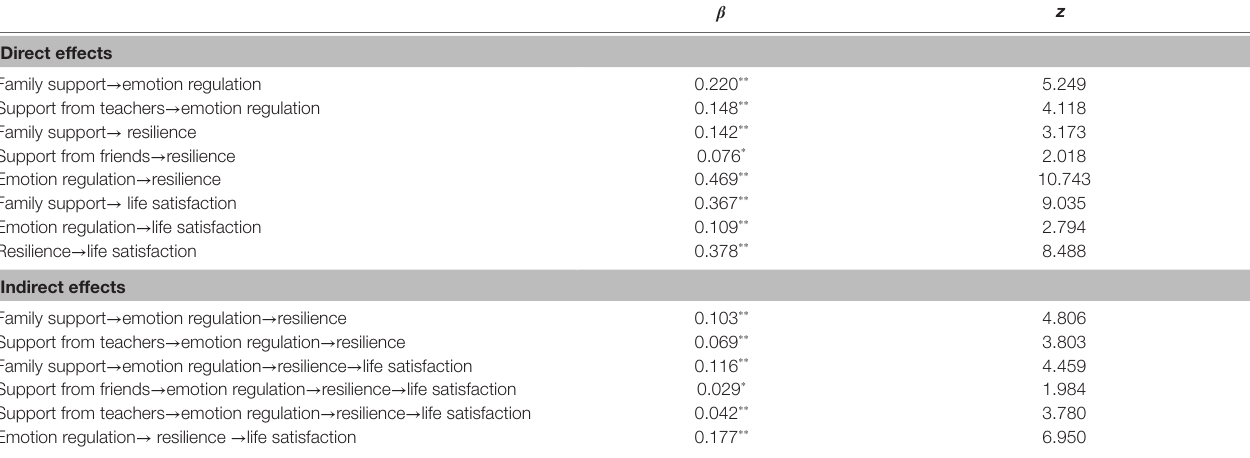
TABLE 3 | Direct and indirect